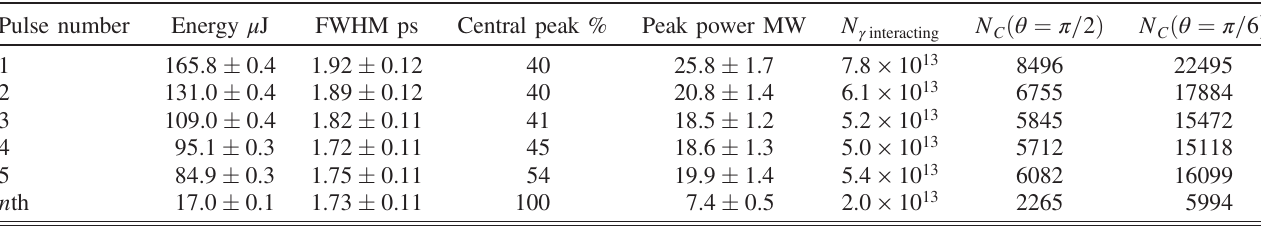
TABLE II. Summary of the measured properties and calculated peak powers of the pulses using the compressor transmission efficiency of 75%. The n th pulse is representative of the mean of the steady-state pulses. The number of interacting photons ( N γ was calculated by calculating the proportion of the total pulse energy within the full width at half maximum (FWHM) of the central peak. This was scaled assuming 75% compressor transmission and 60% frequency doubling efficiency. The number of Compton- scattered photons is calculated from this assuming ILC electron beam parameters detailed in Sec. IV for two possible laserwire collision angles of π = 2 and π = 6